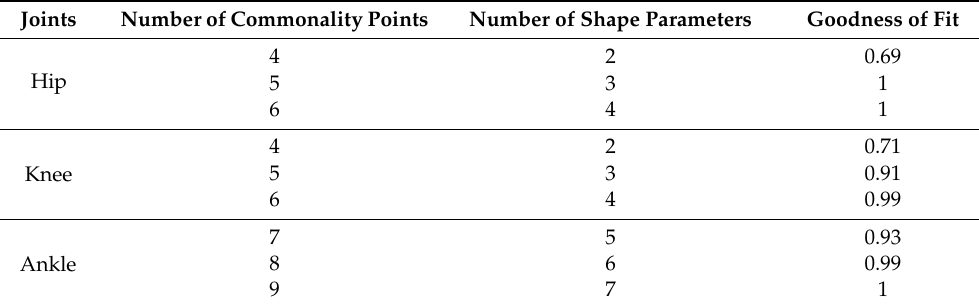
Table 1. The three groups of curve fitting results of joints.